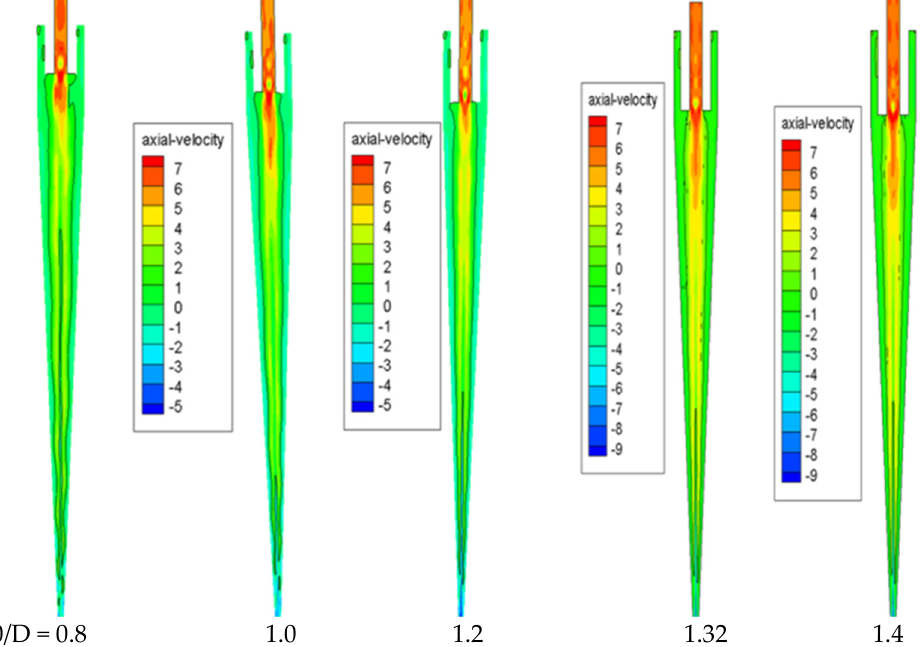
Figure 10. Figure 10 Locus of Zero Vertical Velocity of mini-hydrocycloness with different vortex finder depth.